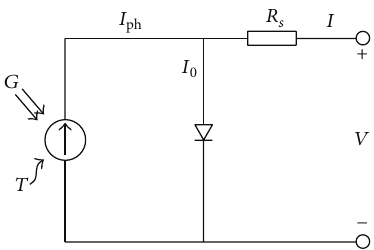
Figure 2: Solar cell circuit diagram of a single parallel diode. 𝐼 ph : photocurrent, 𝐼 0 : diode saturation current, 𝑅 s : serial resistance, 𝑇 : ambient temperature, 𝐺 : ambient irradiance, and 𝑉 : output